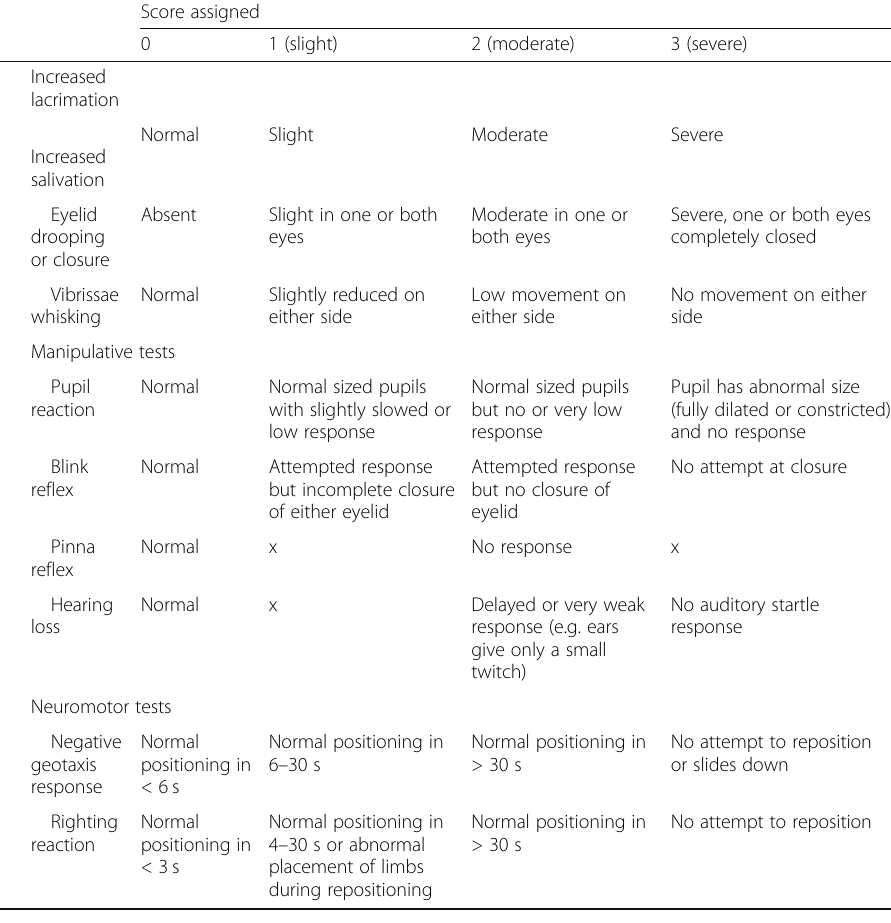
Table 2 Functional observational battery of neurological and clinical signs (Continued) Score